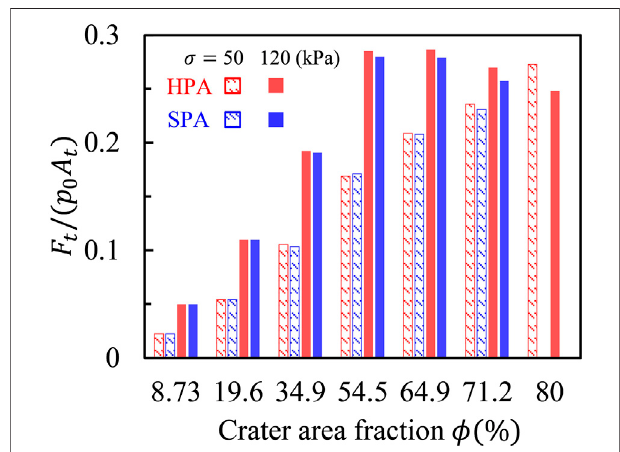
FIGURE 9 | Normalized total suction force F t / ( p 0 A t ) as a function of crater area fraction ϕ for crater arrays with fi xed crater shape (SCS with b / a (cid:3) 2 / 3) and matrix Young ’ s modulus E (cid:3) 141.9 kPa. Red represents hexagonal pattern arrays (HPA) and blue for square-patterned arrays (SPA). Shaded bars are for small preload case ( σ (cid:3) 50 kPa) and solid bars are for large preload case ( σ (cid:3) 120 kPa). [reprinted with permission from (Wang et al.,